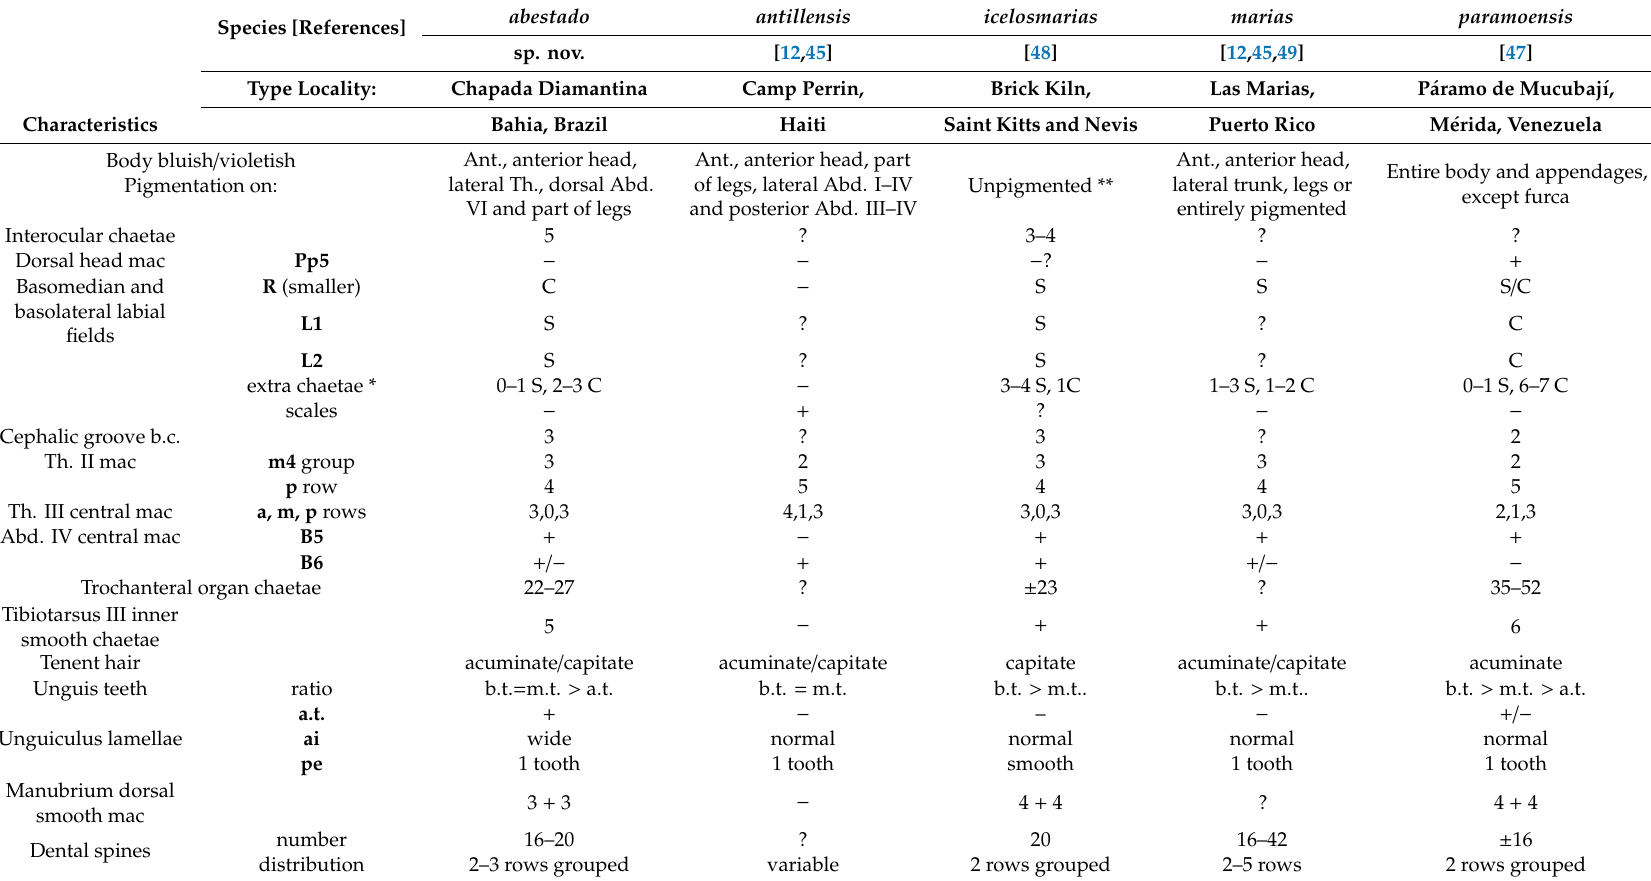
Table 2. Comparison among Dicranocentrus species of the marias group from the New Word with similar morphology (head S series with 7 mac, basomedian